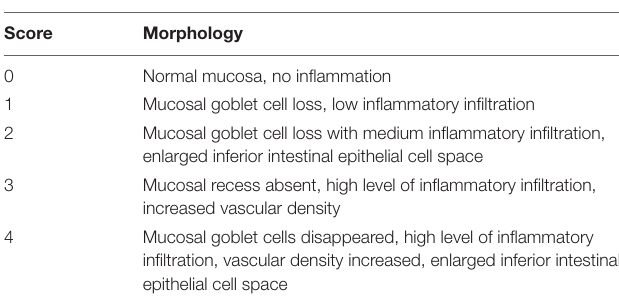
TABLE 2 | Histological